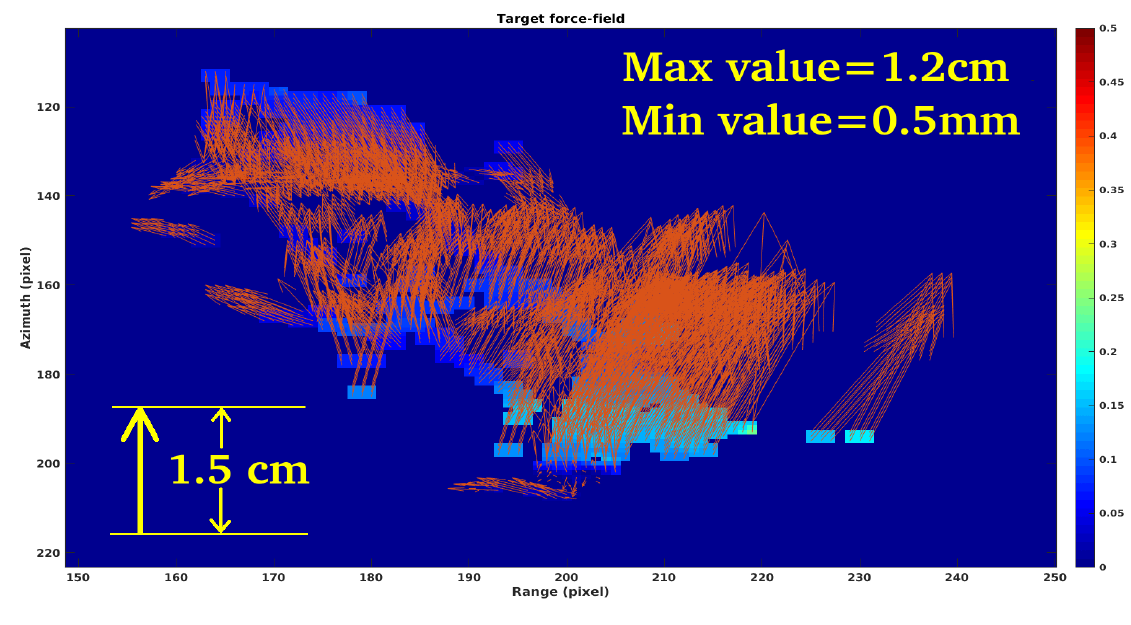
Figure 22. Complex velocity field.